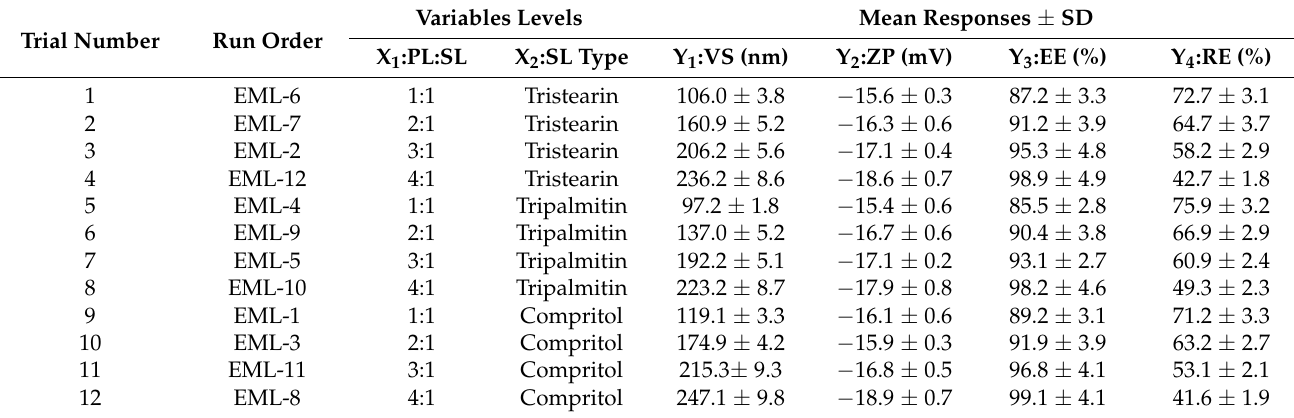
Table 2. Variables and responses for RLX-EMLs experimental runs prepared based on a 4 1 3 1 factorial